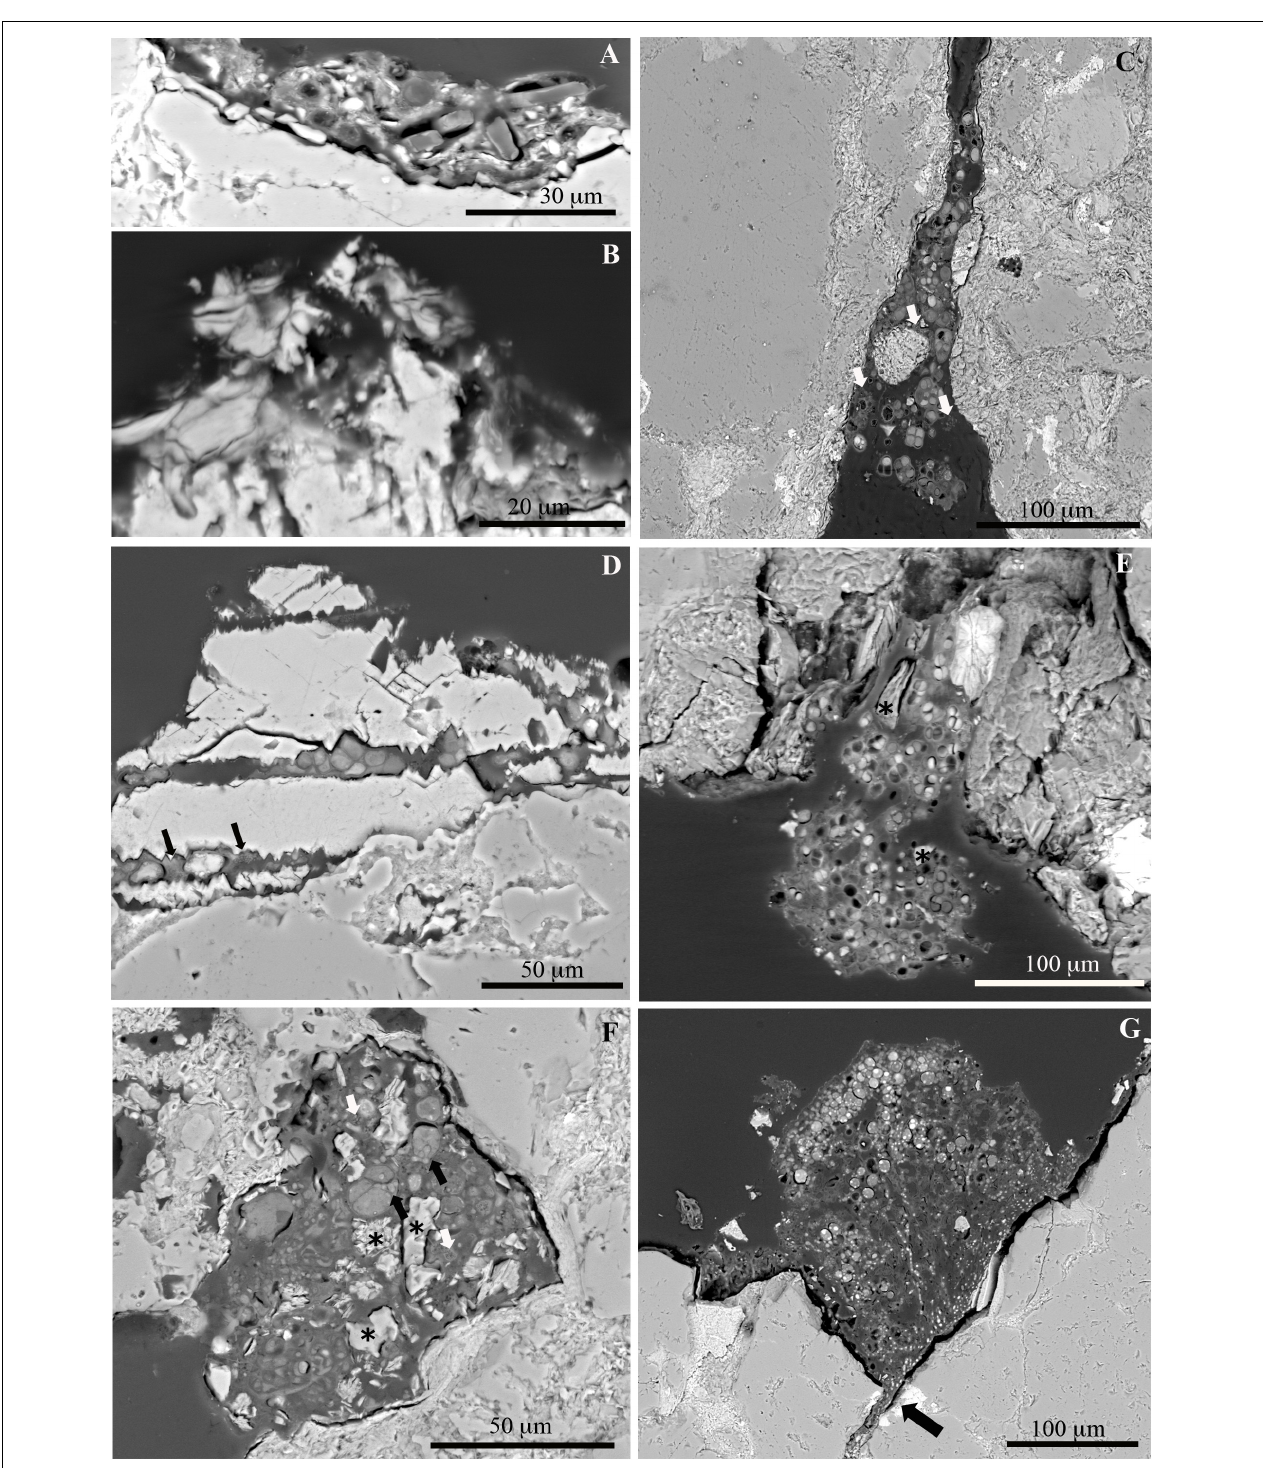
FIGURE 6 | SEM-BSE images of different succession stages of microbial and lichen colonization of moraine rocks. Diatom cells (A) and grain mineral matrix (B) situated on the rock surface at rocks close to the glacier forefront. Endolithic cyanobacteria-dominated communities (C) and algal communities (D) at rocks being ice-free for ca. 13 years. Arrows indicate the presence of non-photosynthetic bacterial cells in both microbial communities. Endolithic cyanobacteria-dominated communities in fissures (E) , and mixed microbial communities inside epilithic cavities (F) of rocks being ice-free for ca. 23 years; these contain small mineral fragments ( ∗ ) which could be the result of microbial-mineral interactions. Black arrows in (F) indicate lichen mycobiont-photobiont interactions. Colonization of an epilithic lichen thallus on a rock being ice free for ca. 23 years (G) , showing endolithic penetration of mycobiont cells (black arrow).